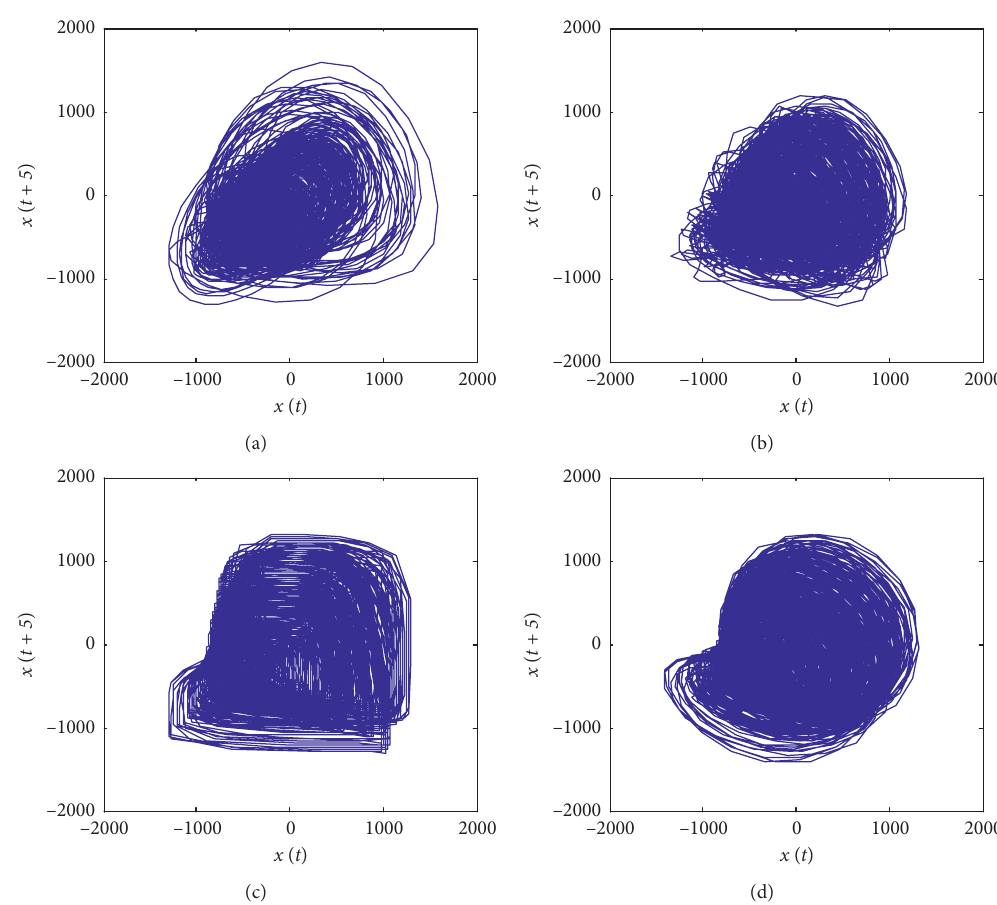
Figure 15: Phase diagrams for the vibration signal: (a) the noise reduction result by EMD thresholding; (b) the noise reduction result by wavelet thresholding; (c) the noise reduction result by AMMF; (d) the noise reduction result by